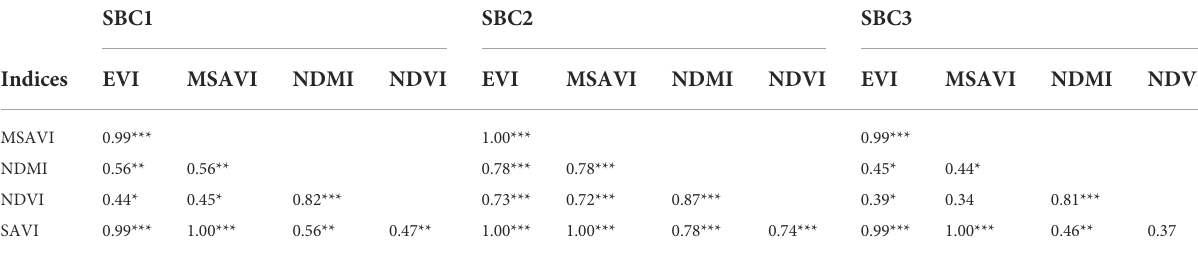
TABLE 2 Pearson correlation coef fi cients between the normalized difference vegetation index (NDVI), normalized difference moisture index (NDMI), enhanced vegetation index (EVI), soil-adjusted vegetation index (SAVI), and modi fi ed soil-adjusted vegetation index (MSAVI) of the study sub-catchments SBC1, SBC2, and